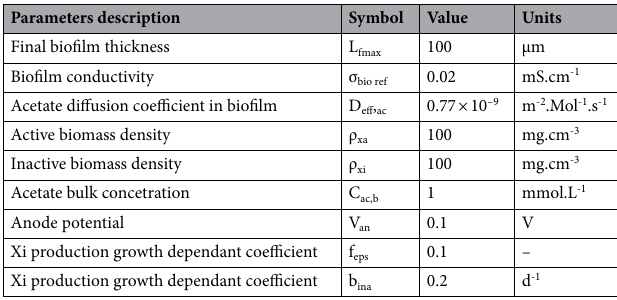
Table 2. Summary of reference conditions.